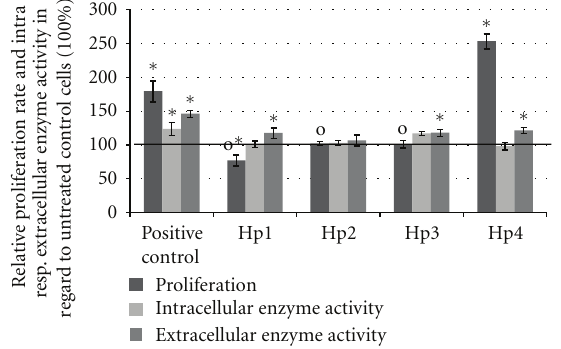
Figure 2: Results of relative proliferation (BrdU incorporation, representative with n = 8) and intracellular (MTT-reduction) and extracellular enzyme activity (WST-1 reduction) of NHDF treated with 10 μ g/mL St. John’s Wort polysaccharides for 48 h. As positive control, 10% FCS was used. Values were normalized to untreated cells (—: untreated control = 100%). n = 24. Error bars = SE; ∗ P < 0 . 05 compared to untreated cells and o: P < 0 . 05 to Hp4.